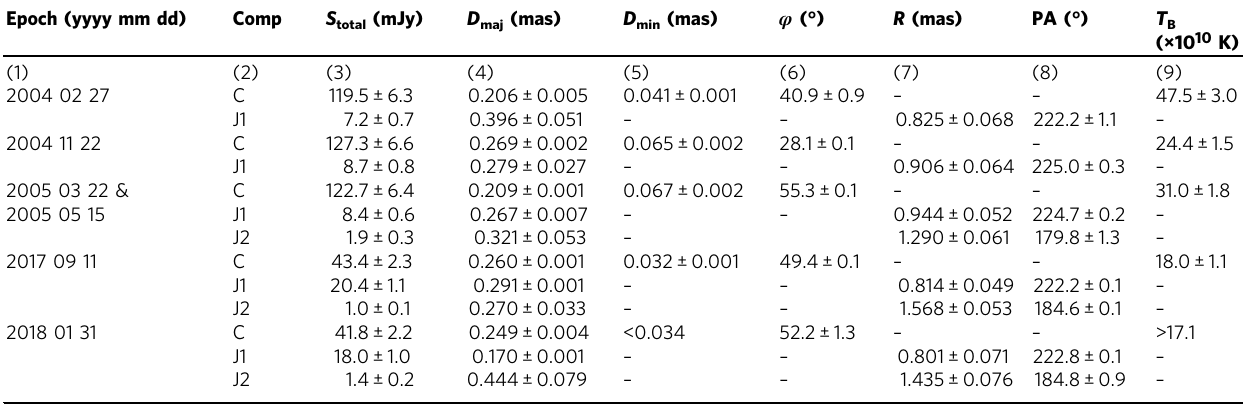
Table 1 Model fi tting parameters.